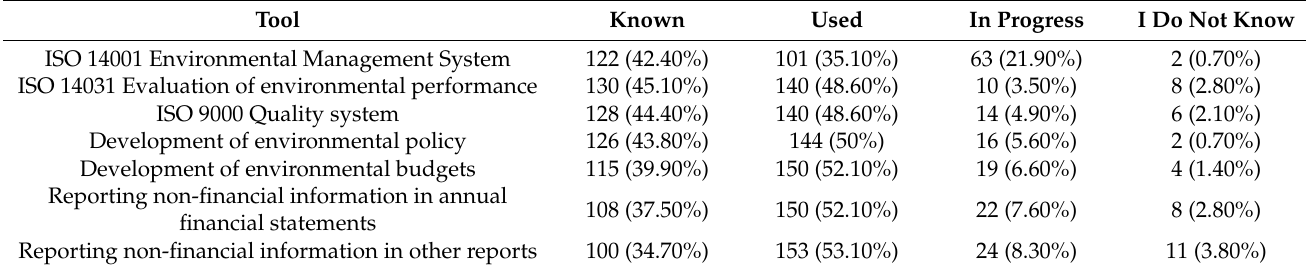
Table 6. Level of implementation of international standards in environmental